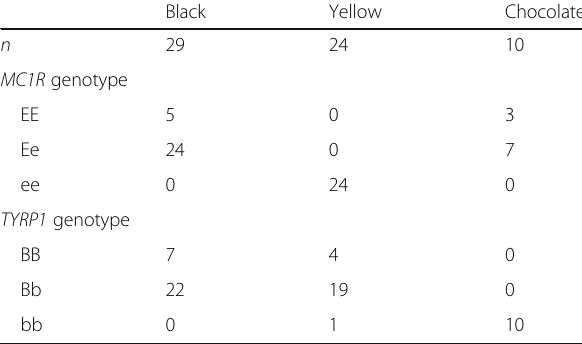
Table 2 Colour genotypes of 63 Labrador retrievers Black